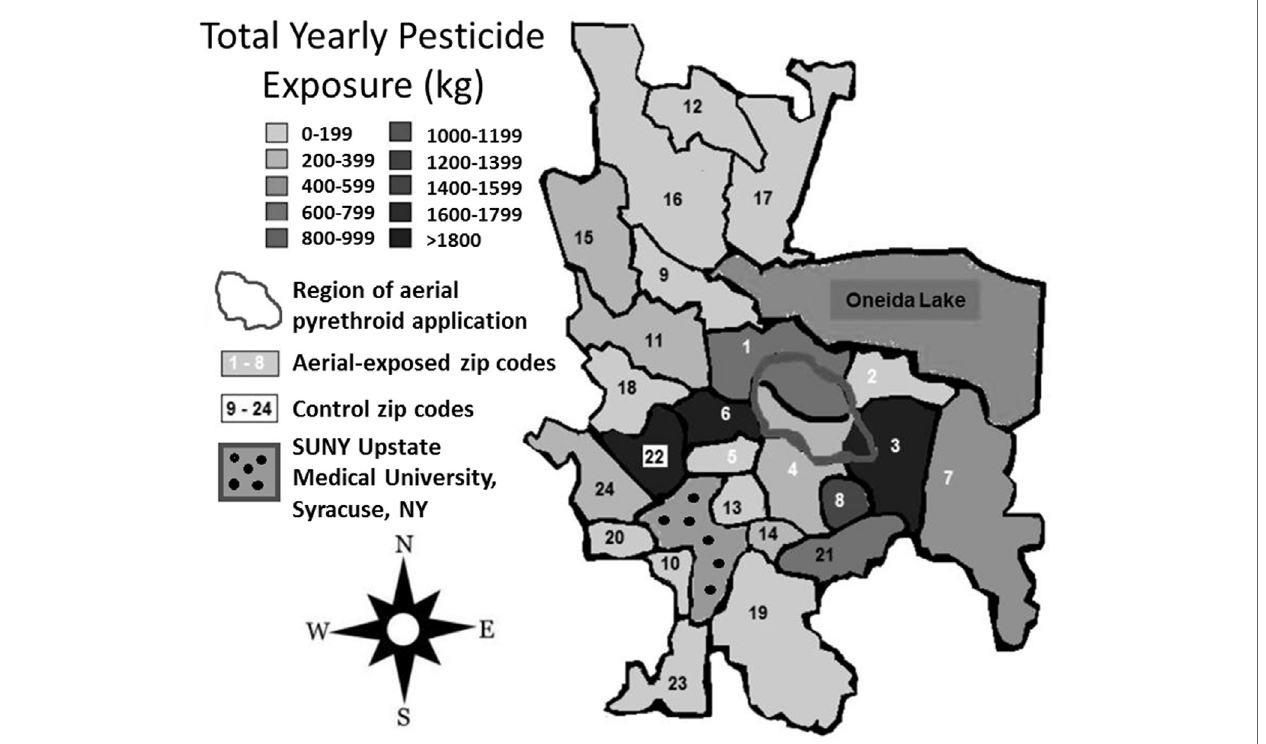
FigUre 1 | regional pesticide exposure . Mean yearly pesticide exposure for each zip code is shown in kilograms. These levels were determined using the most recently available data from the New York State Department of Environmental Conservation Mandated Reporting Database. Total pesticide exposure includes pyrethroids, organophosphates, and other pesticide families regardless of class or application method employed. Aerial-exposed zip codes are numbered 1–8 in white, and control zip codes are numbered 9–24 in black. Note that there was no statistical difference between mean concentration of pesticide exposure between aerial-exposed zip codes (49 kg/km 2 ) and control zip codes (9 kg/km 2